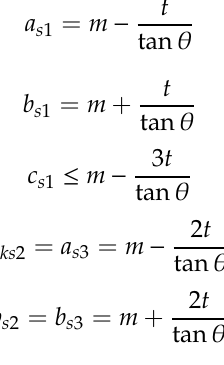
Figure 28. Dimensions of the parts of the keystone for use in square vaults: ( a ) rough on both sides; ( b ) smooth from above; ( c ) smooth from below; and ( d ) both sides smooth.